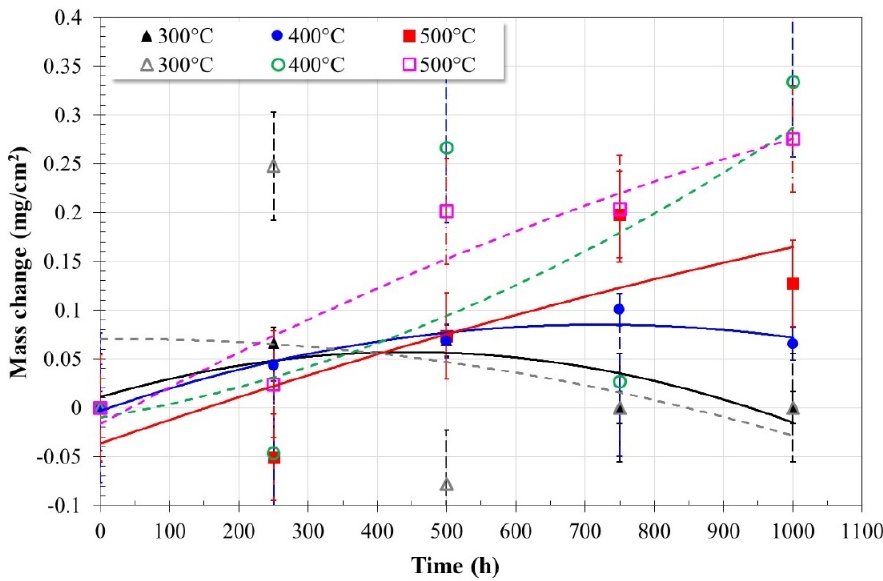
Figure 1. Mass change of Ni20Cr alloy immersed in Solar Salt (continuous lines) and Ternary salt (dotted lines).